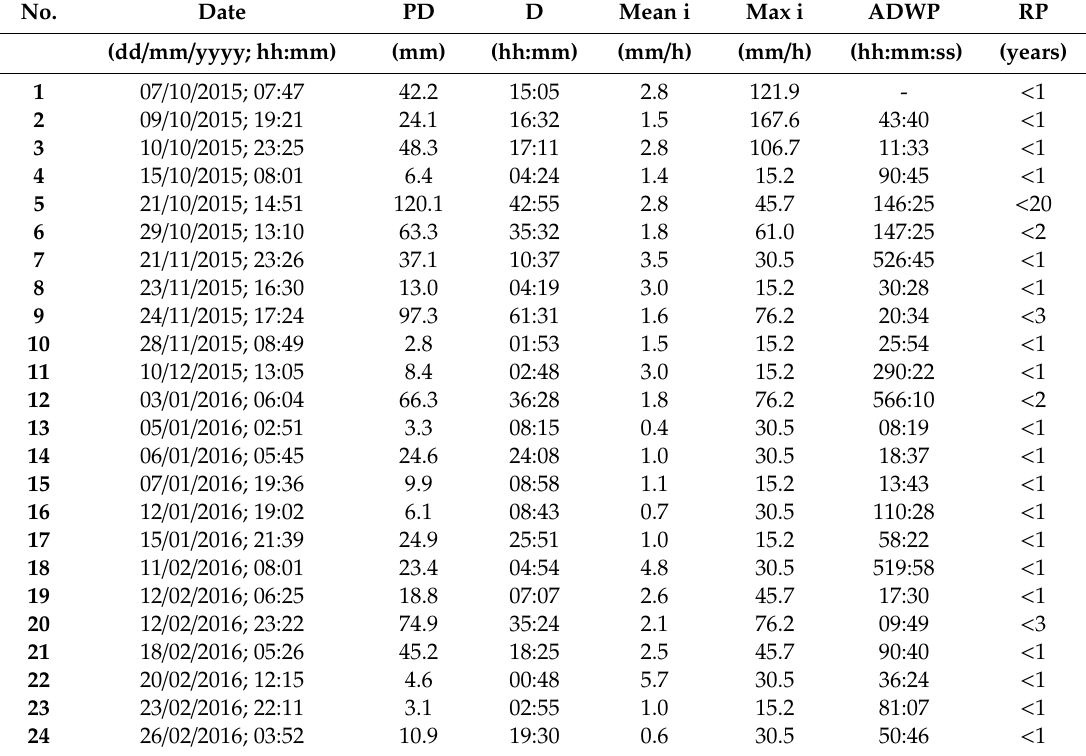
Table1. HydrologicalcharacteristicsofeachrainfalleventcollectedfromOctober2015toSeptember2016 on the experimental site. PD: precipitation depth, D: rainfall duration, Mean i: mean rainfall